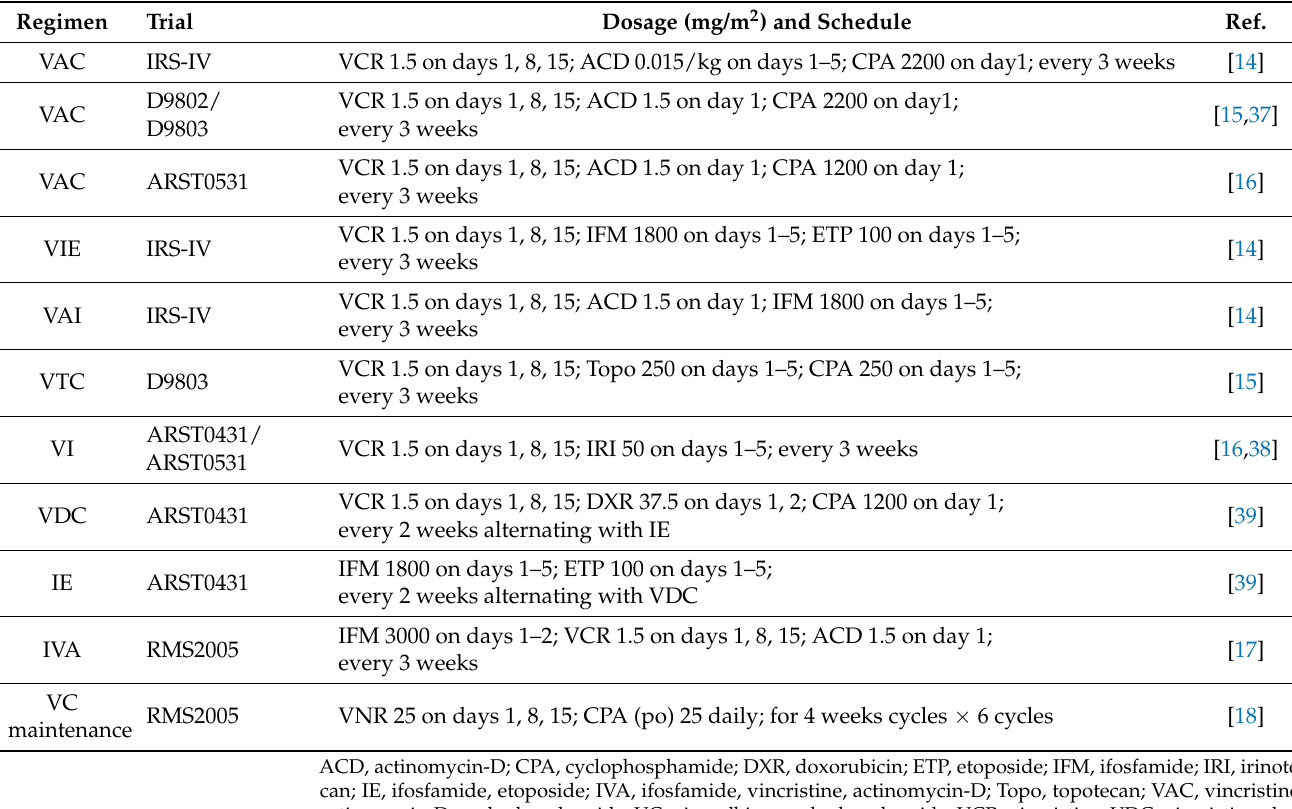
Table 2. Chemotherapy regimens available for newly diagnosed